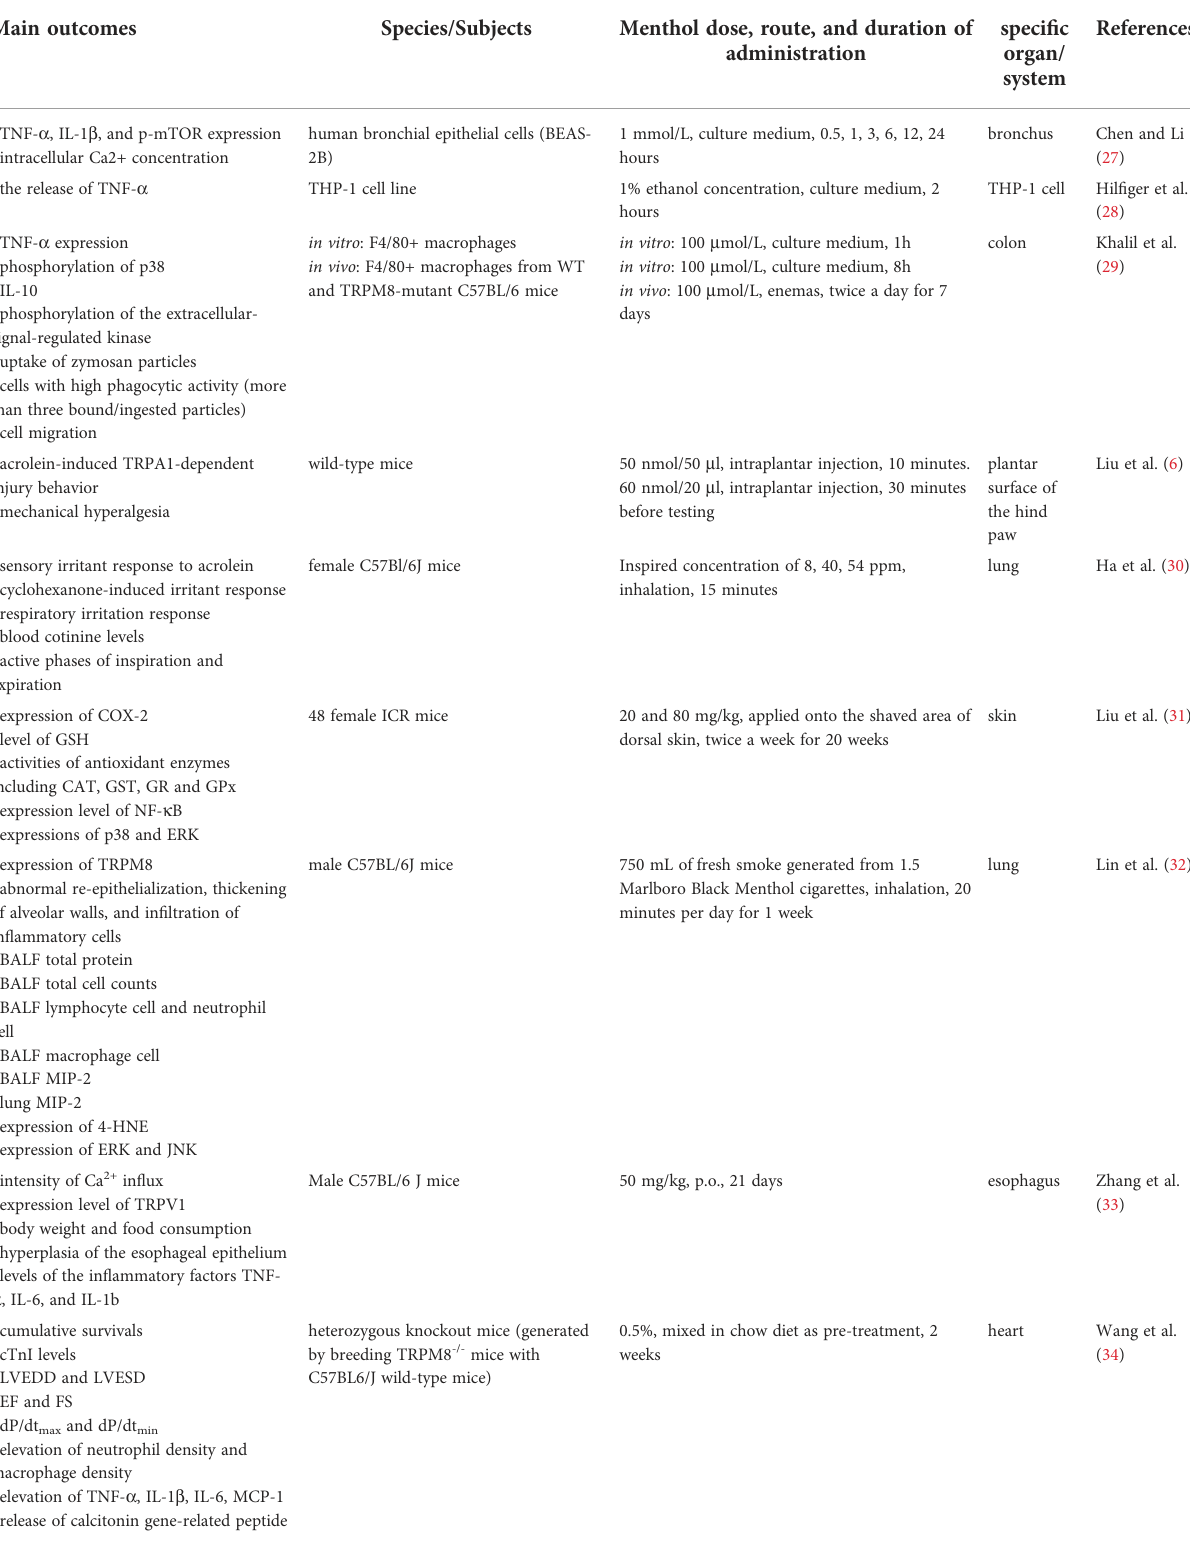
TABLE 1 Anti-in fl ammatory activity of menthol examined by human, in vivo , and in vitro